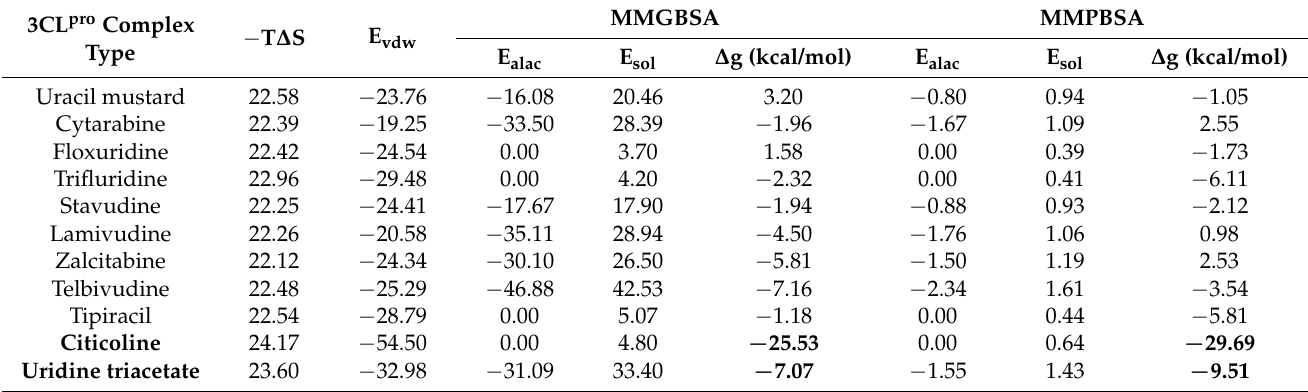
Table 4. The MMPBSA and MMGBSA data for the binding of pyrimidone containing-pharmaceuticals to 3CL Pro of SARS-CoV-2. 3CL pro